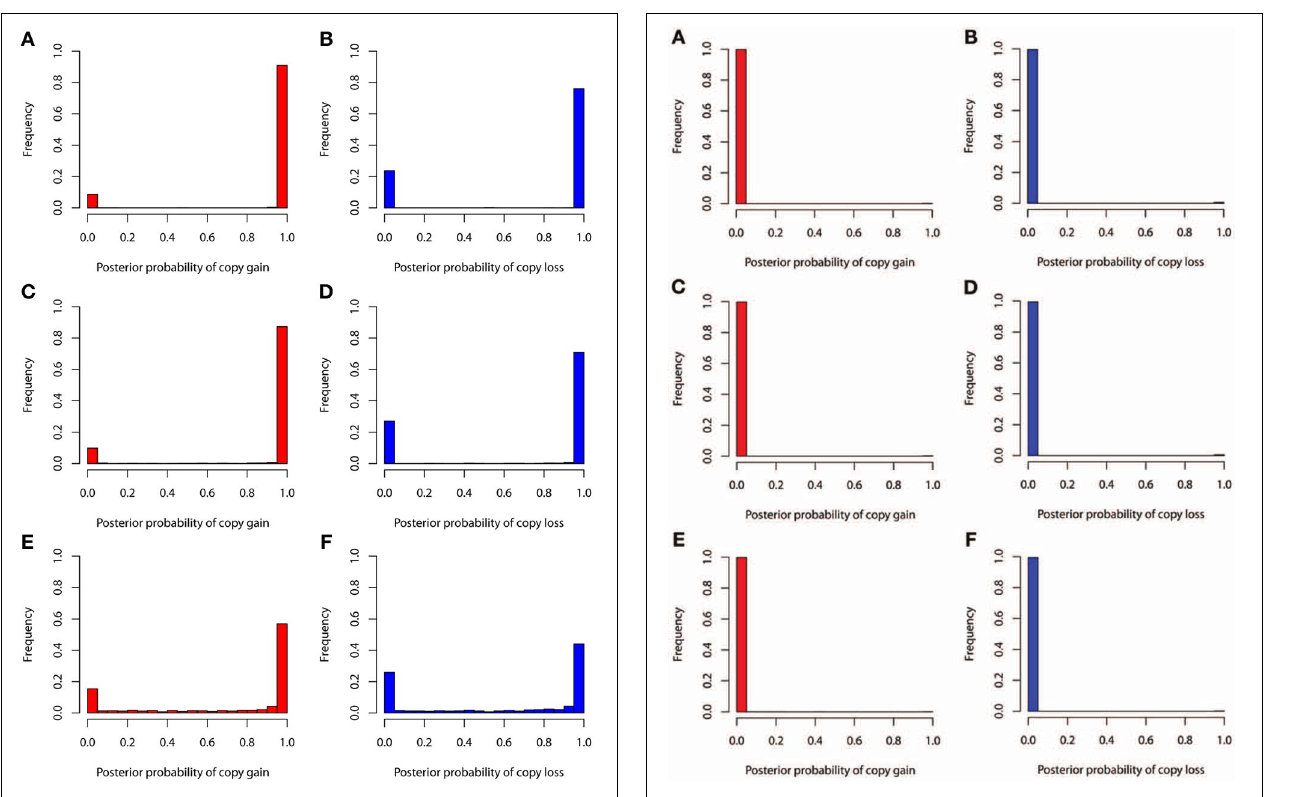
true positive of copy gain, (B) for true positive of copy loss, (C) for false positive of copy gain, and (D) for false positive of copy